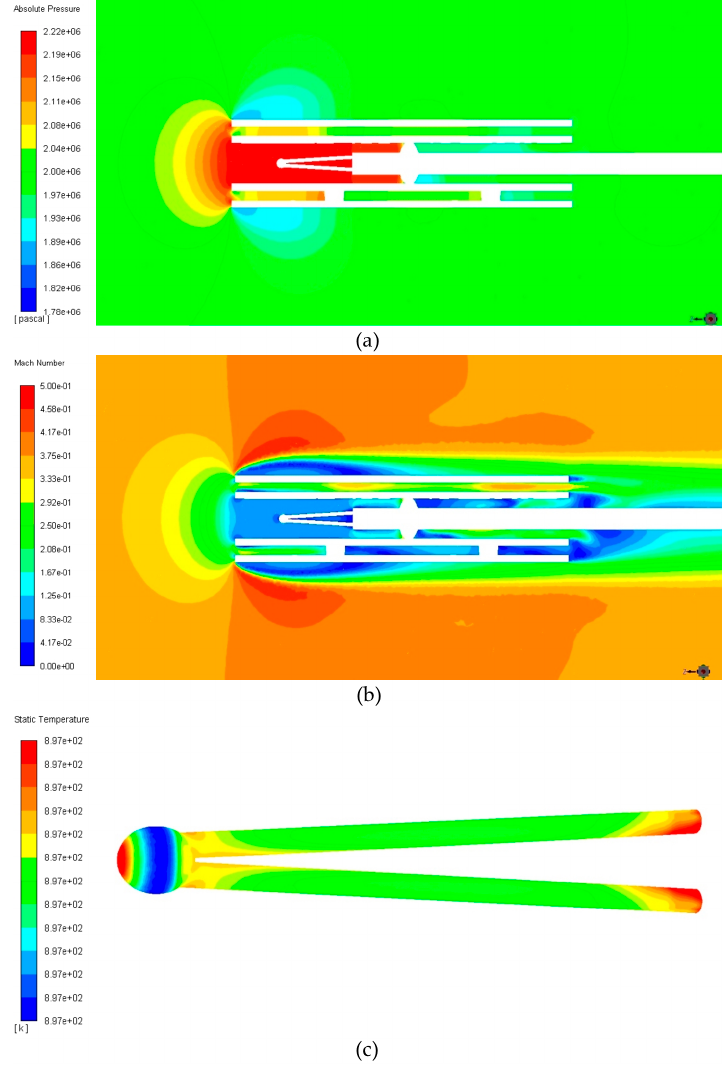
Figure 9. Contour plots of ( a ) pressure and ( b ) velocity distributions for the dual-screen thermocouple (DST); ( c ) the temperature distributions of the thermocouple wire and solder ball.